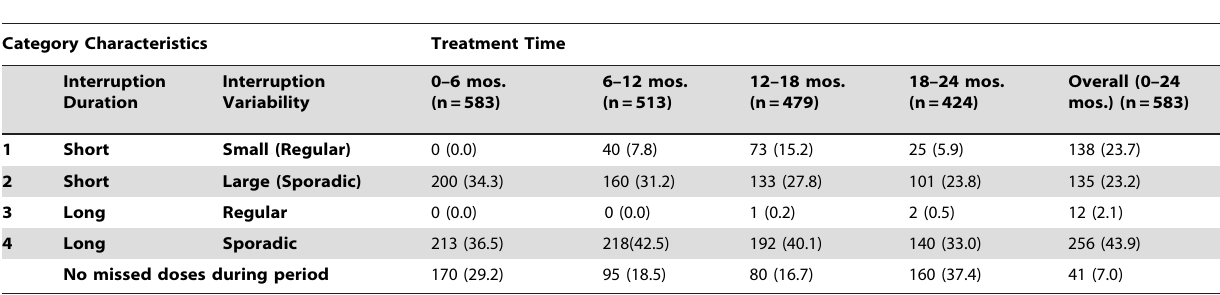
Table 3. Treatment patterns among MDR TB patients, by 6 month intervals of treatment (n=583).